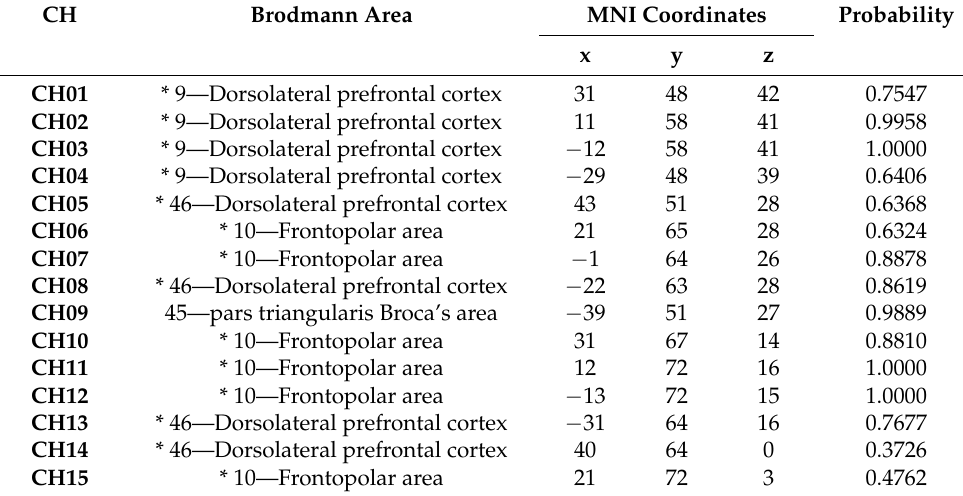
Figure 1. ( a ) Positions of fNIRS channels. ( b ) Fifteen optodes (eight sources and seven detectors) were attached to the forehead in a 5 × 3 lattice pattern forming 22 measurement channels (in frontal view). ( c ) The 3D MNI coordinates of the fifteen optodes in a different view. Table 3. Locations of all fNIRS